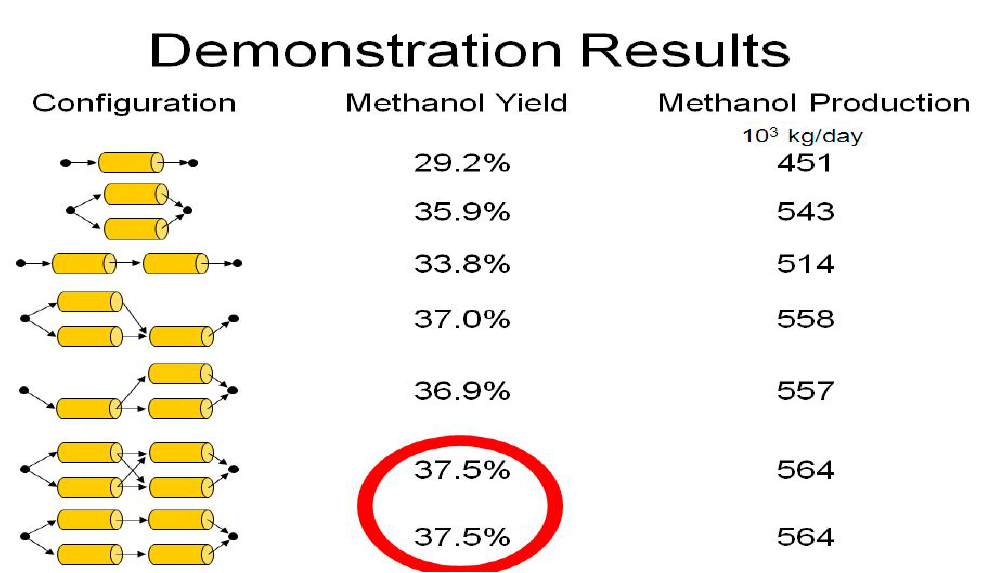
Figure 5. Methanol yield and MP for different reactor configurations at a=1.